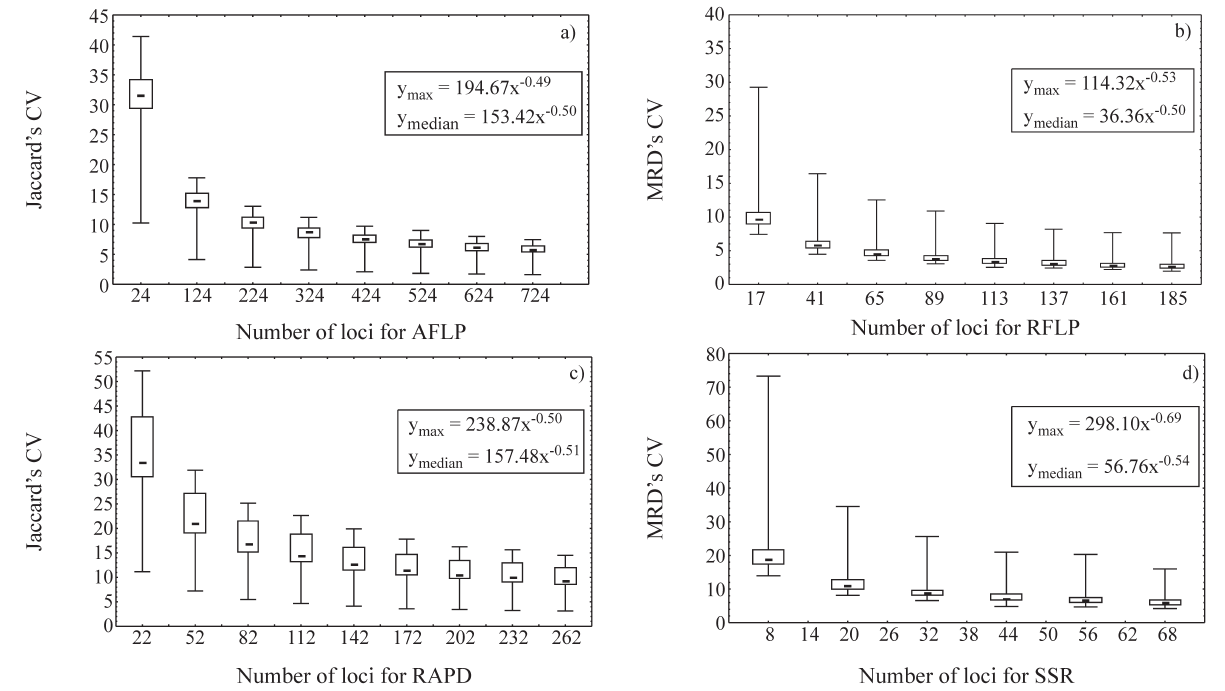
Figure3 -Boxplotsshowingsamplingvariationofthegeneticdistances(GD)valuesbetweendifferentmaizeinbredlinesusingbootstrapanalysisacross different marker systems. Key: a, c = dominant markers; b, d = codominant markers; x = number of loci; y max = exponential function adjusted relative to the highest coefficient of variation (CV) value; y median = exponential function adjusted relative to the median CV value; RAPD = random amplified poly- morphic DNA; RFLP = restriction fragment length polymorphism; AFLP = amplified fragment length polymorphism; SSR = simple sequence repeat markers.